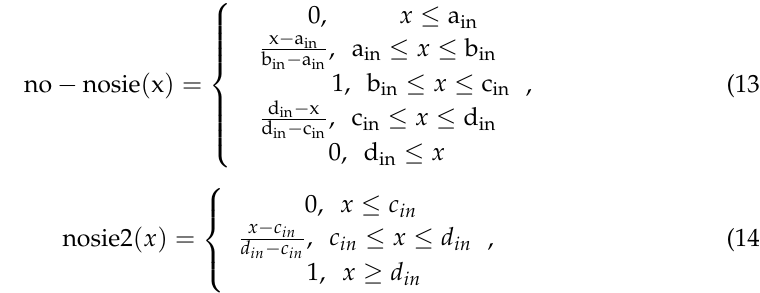
Figure 4. Four input attributions of three membership functions.